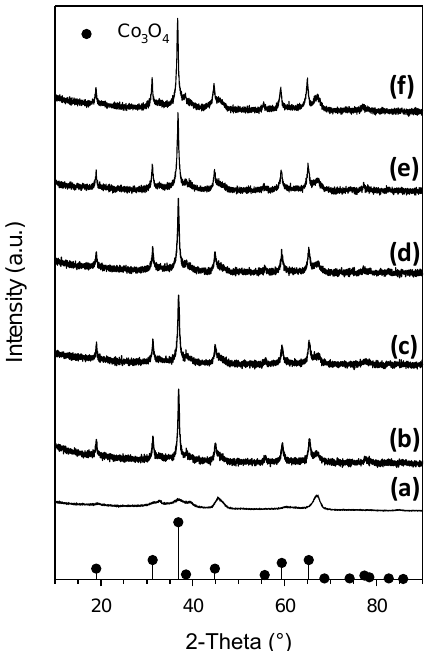
Figure 1. XRD for ( a ) 25%Co/Al 2 O 3 , ( b ) 25%M (M = 5%Ni-95%Co)/Al 2 O 3 , ( c ) 25%M (M = 10%Ni-90%Co)/Al 2 O 3 , ( d ) 25%M (M = 25%Ni-75%Co)/Al 2 O 3 , and ( e ) 25%M (M = 50%Ni-50%Co)/Al 2 O 3 .